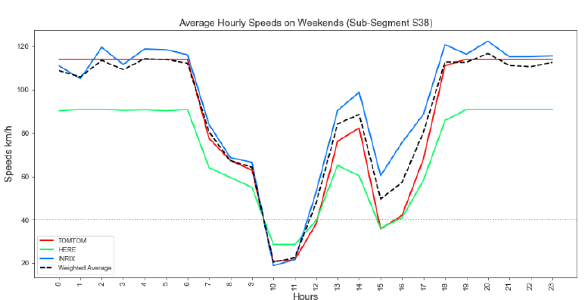
Figure 7: Time-of-day average speeds on weekends for the virtual sub-segment before the bottleneck location (S38).